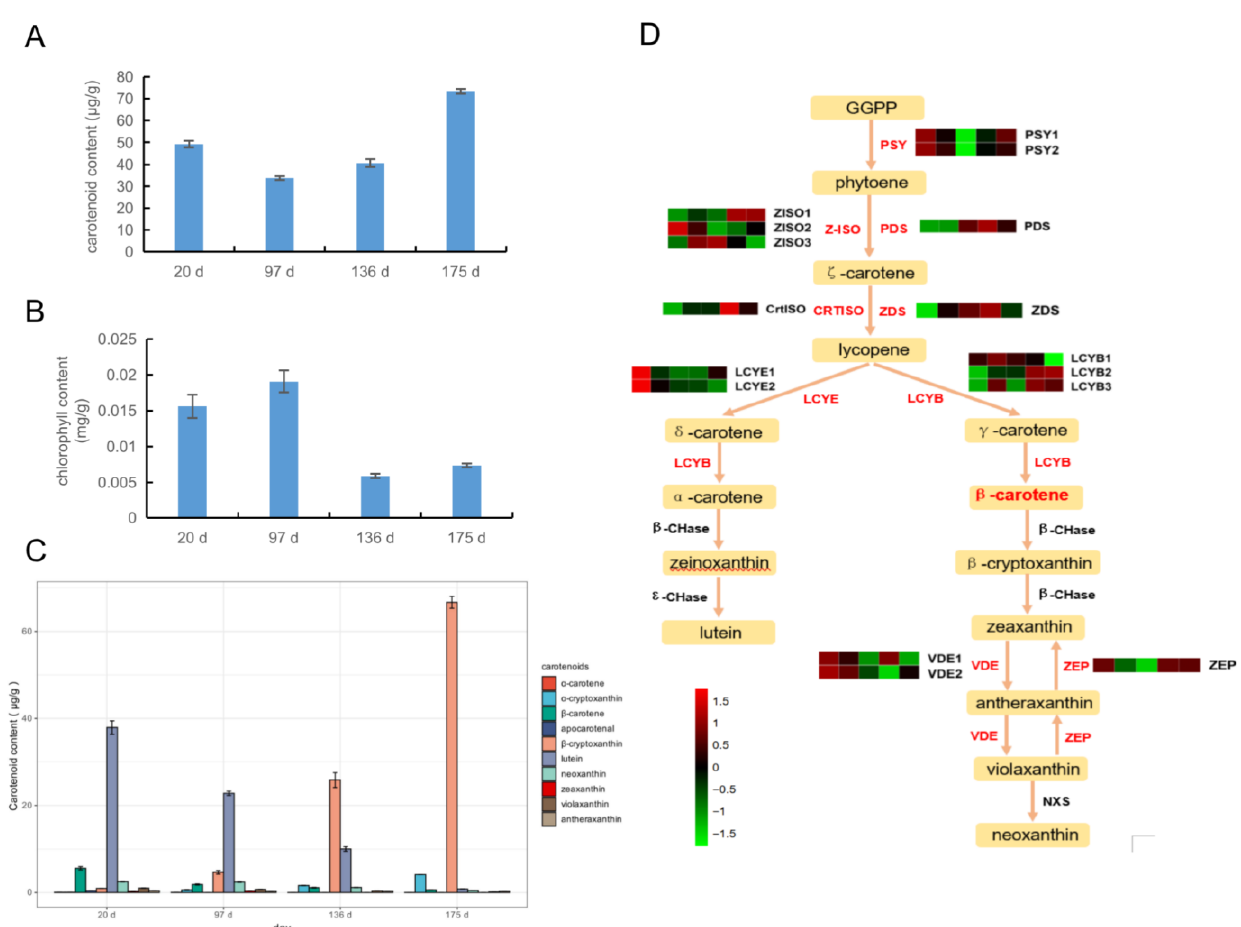
Figure 4. Comprehensive analysis of carotenoids. ( A ): Carotenoids content in four periods. The X axis is the content of carotenoids (μg/g), and the Y axis is the carotenoids. ( B ): Chlorophyll content in four periods. The X axis is four periods, and the Y axis is chlorophyll content (mg/g). The error bars in the figure is standard error. ( C ): Various carotenoid contents in four periods. The X axis is the content of carotenoids (μg /g), and the Y axis is the type of carotenoids. ( D ): Comprehensive metabolic map of carotenoids. The gene name is on the right side of the heat map, and the FPKM value of each gene is expressed in different colors, with five cells from left to right representing samples of 20 d – 176 d, respectively, and the color scale from dark blue to bright red represents relative expression levels −1.5– 1.5. The name of the enzyme gene is on the side, and the FPKM of each gene is expressed in different colors; the five cells from left to right represent samples of 20 d – 176 d.